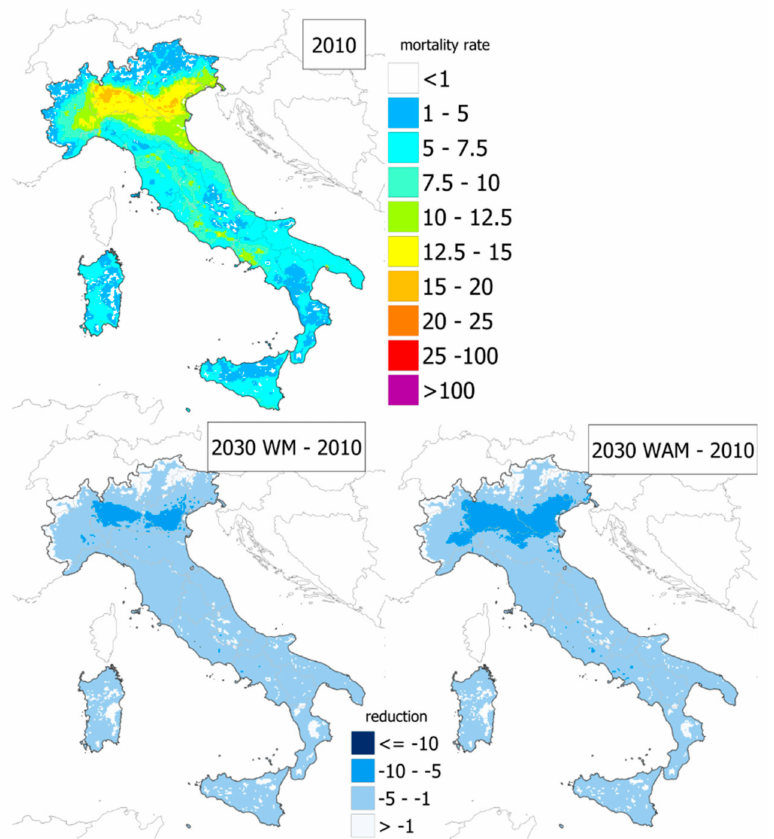
Figure 4. PM 2.5 mortality rate (number of deaths for 10.000 inhabitants) in 2010 ( upper left ), variation in mortality rate between 2010 and 2030 WM ( lower right ) and between 2010 and 2030 WAM ( lower left